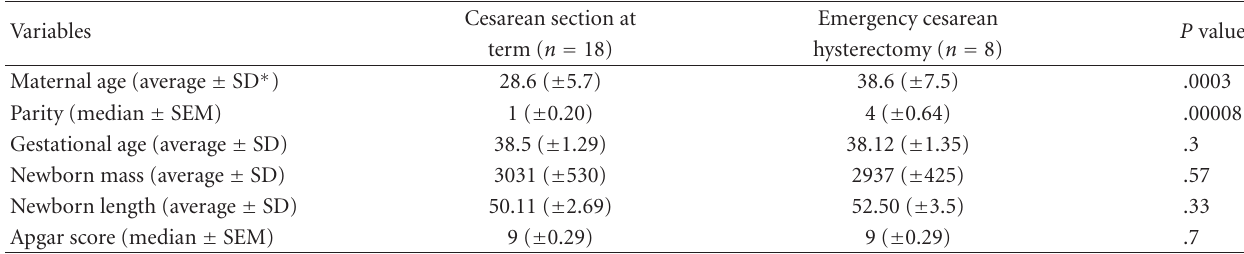
Table 1: Clinical characteristic of patients.